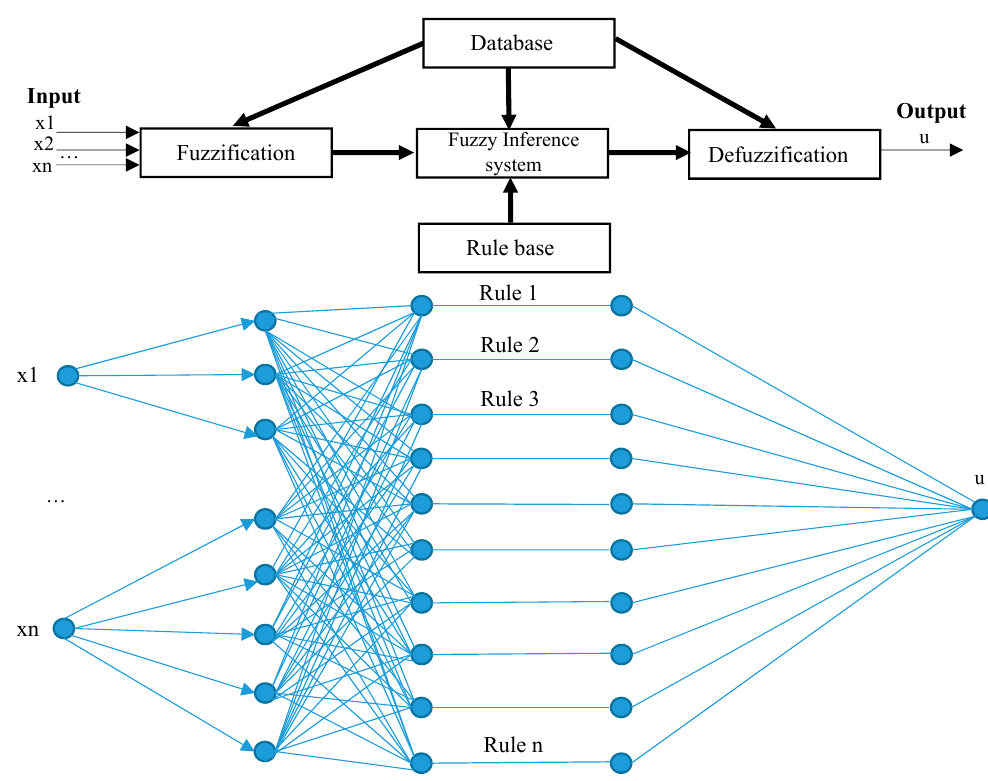
Figure 3. The basic structure of the fuzzy control